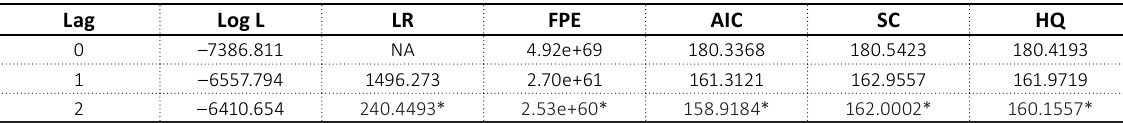
Table A2. Vector auto-regression lag order selection